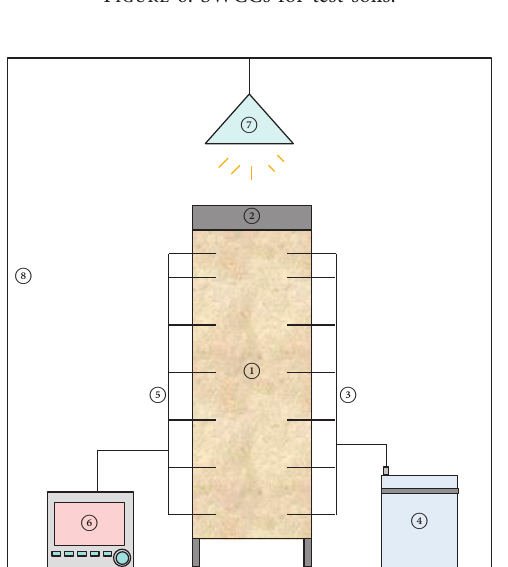
Figure 6: SWCCs for test